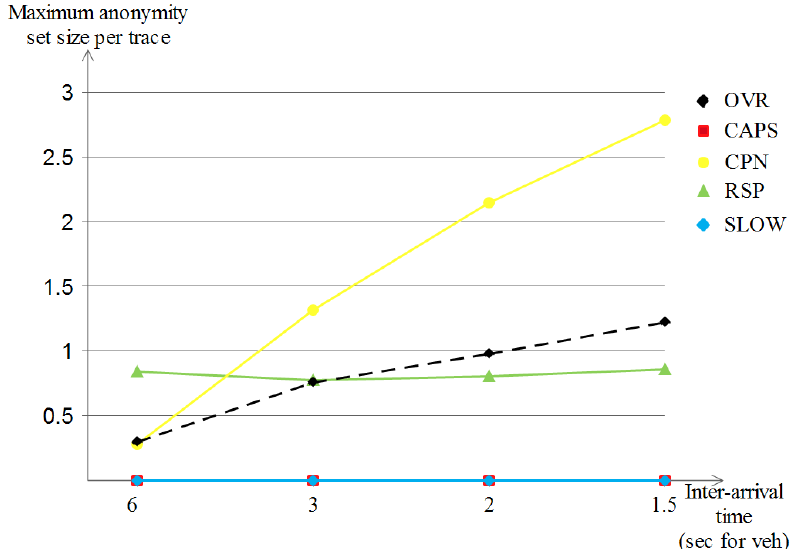
Figure 15. Maximum anonymity set size per trace of privacy schemes in the highway scenario.